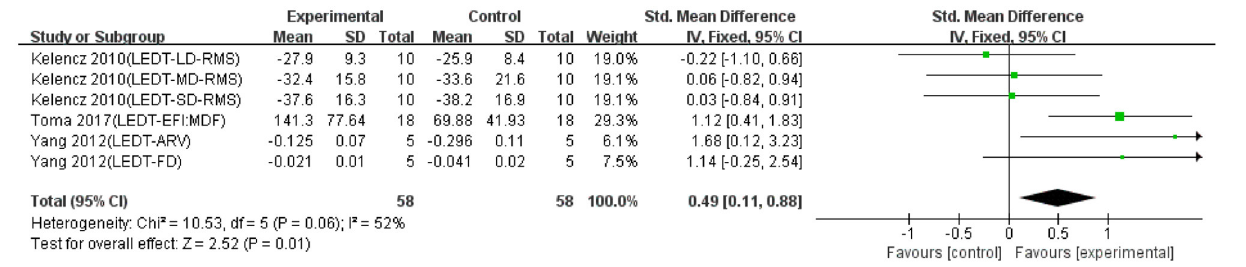
FIGURE 8 | The effectiveness of light-emitting diode therapy (LEDT) on electromyography (EMG) signals of exercise-induced muscle